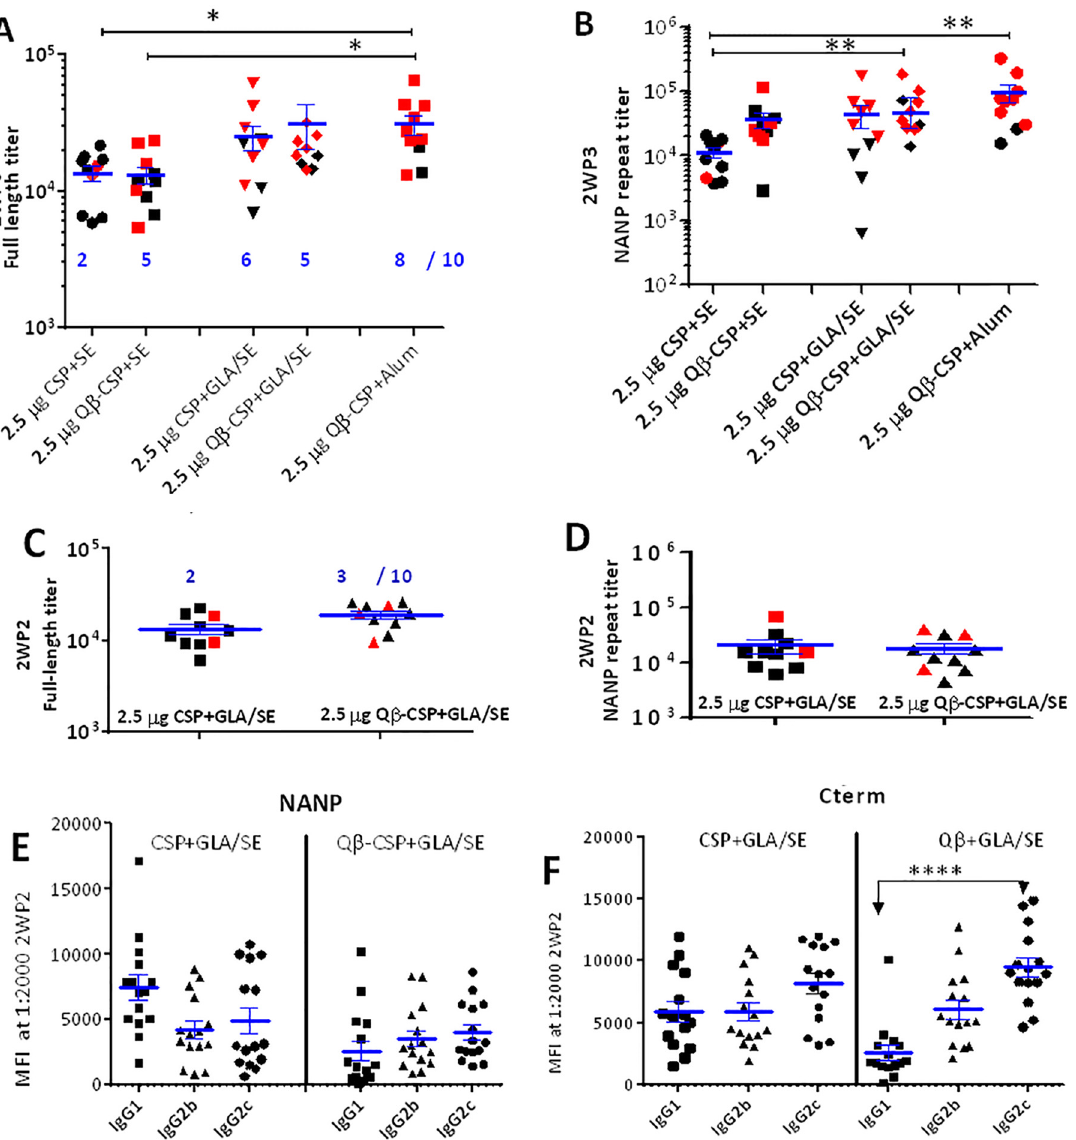
Fig 5. Q β -CSP vs . CSP in SE, GLA/SE and Alum. Groups of 10 mice received 3 doses, 3 weeks apart of 2.5 μ g CSP+SE, Q β -CSP+SE, CSP+GLA/SE, Q β - CSP+GLA/SE or Q β -CSP+Alum. A, B show the mean ± SEM of the full-length and NANP-specific ELISA titers at 2 weeks post third vaccination. ** (p < 0.01); * (p < 0.05); red symbols represent protected mice and number (blue) protected out of 10. C, D, E and F are data from an independent 2-dose study. 15 mice received 2 doses of 2.5 μ g CSP+GLA/SE and Q β -CSP+GLA/SE, three weeks apart. C, D show the mean ± SEM of full-length and NANP-specific ELISA titer from the 10 challenged mice at 2 weeks after the second vaccination. Red symbols were protected mice and number represent protected out of 10 (blue). E, F, IgG1, IgG2b and IgG2c responses of 15 mice measured by Luminex and expressed as MFI at 1:2000 dilution against NANP peptide (E) or C-term protein